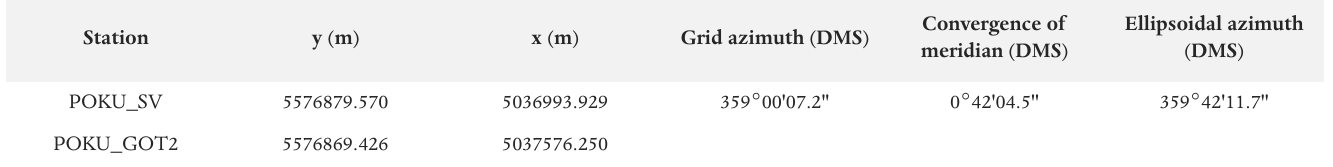
Table 5. Azimuth average value from 36 solutions (VPPS).